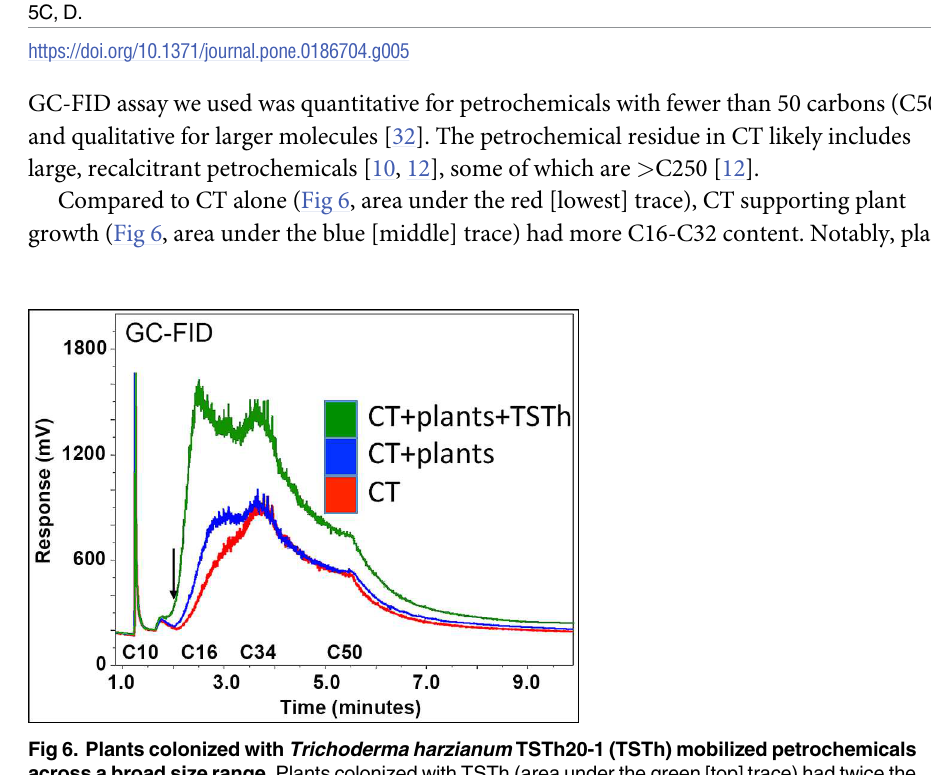
PLOS ONE | https://doi.org/10.1371/journal.pone.0186704 October 19,